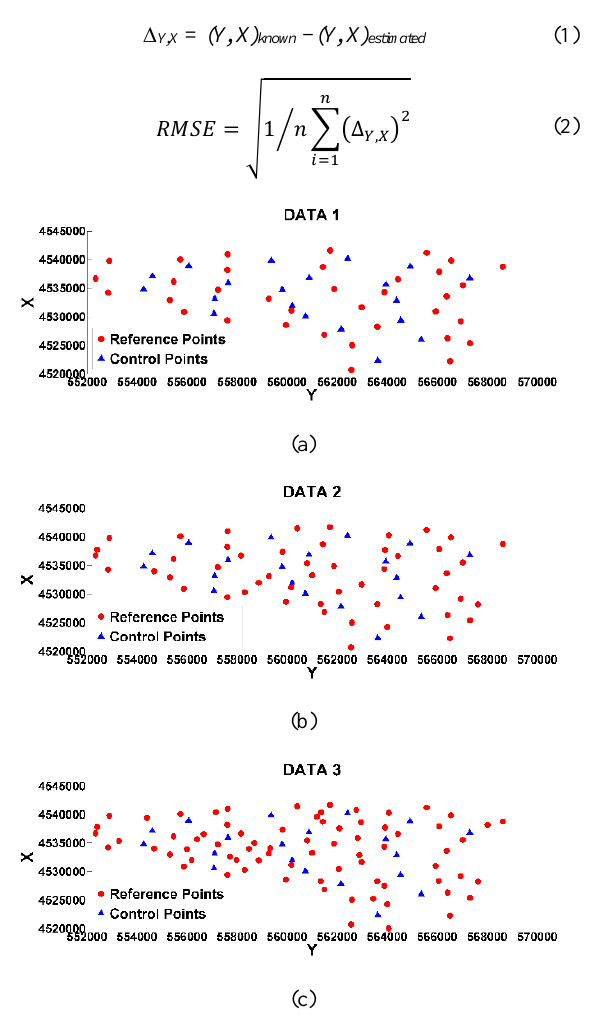
Figure 5. The distribution of reference and control points at the study area: (a) Data 1, (b) Data 2, (c) Data 3.